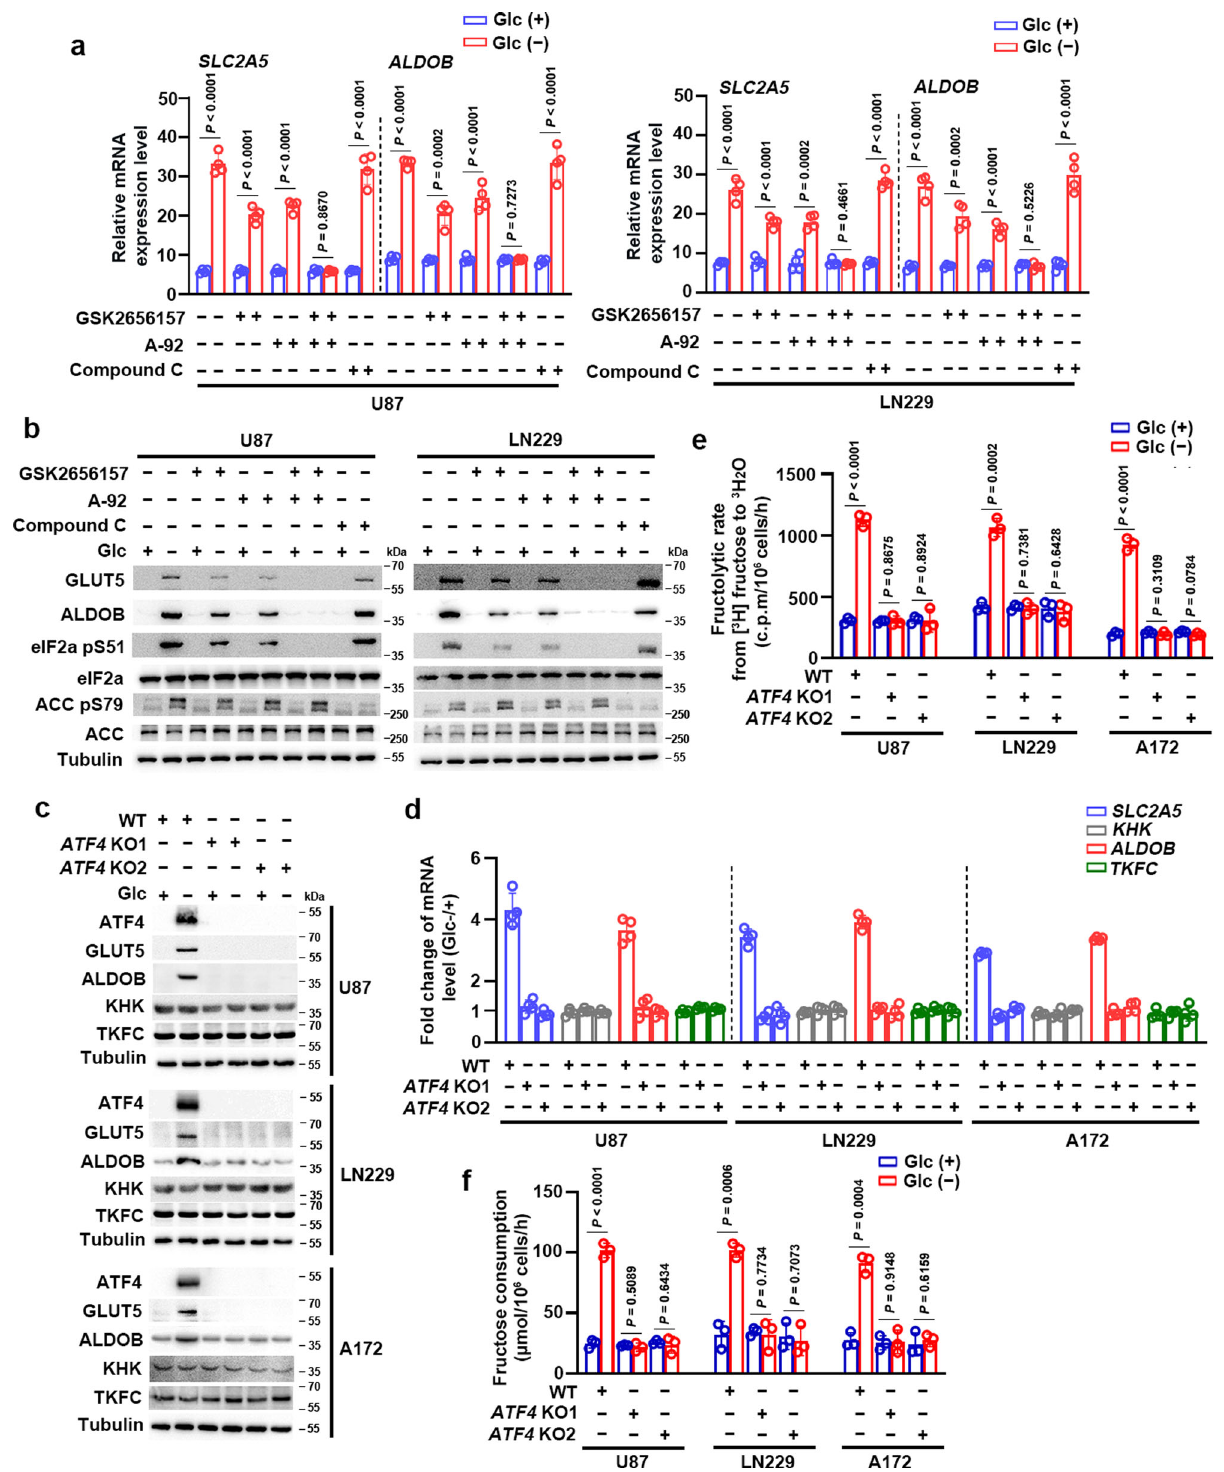
Fig. 2 | ATF4 is required for glucose deprivation-induced fructolysis. a , b U87 and LN229 cells treated without or with glucose deprivation for 18hours in the absence or presence of indicated inhibitors were analyzed by quantitative PCR ( a ) and immunoblotting with indicated antibodies ( b ). Data were normalized with β - actin mRNA levels and presented as relative mRNA expression level ( a ). c , d U87, LN229andA172cellswithoutorwith ATF4 knockout(KO)weredeprivedofglucose for 18h and then analyzed by immunoblotting with indicated antibodies ( c ) and quantitativePCR( d ).Datawerenormalizedwith β -actinmRNAlevelsandpresented as fold change induced by glucose deprivation ( d ). e U87, LN229, and A172 cells without or with ATF4 KO were deprived of glucose for 18hours. The fructose